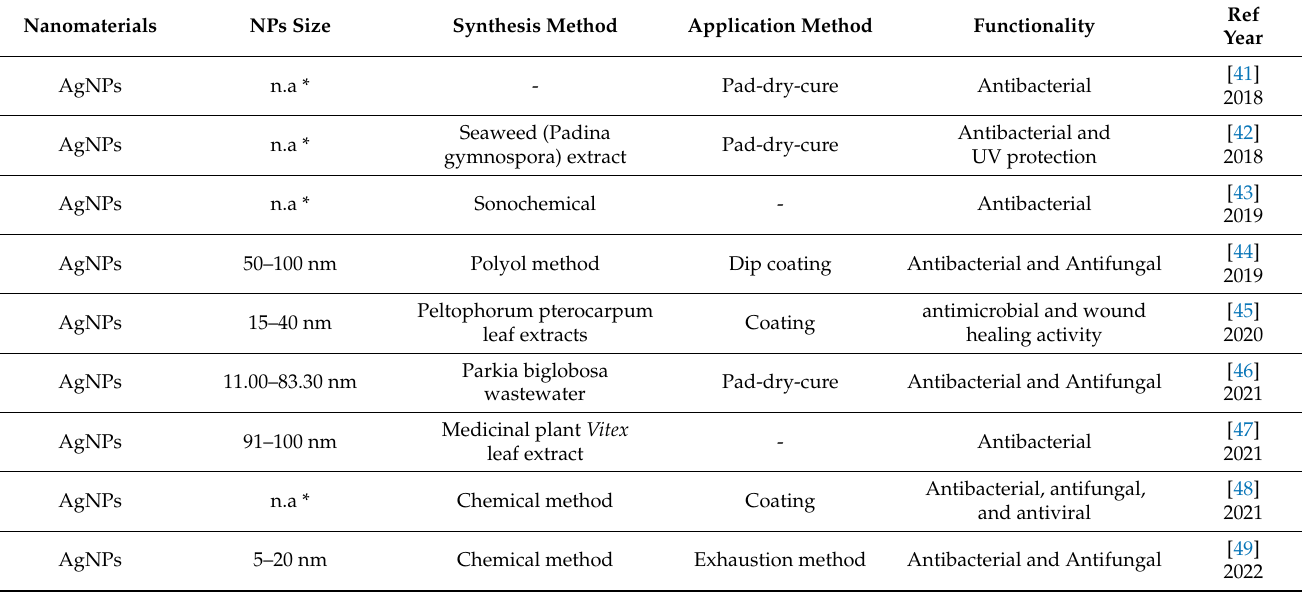
Table 1. Summary of the functionalization of cotton fabrics integrated with